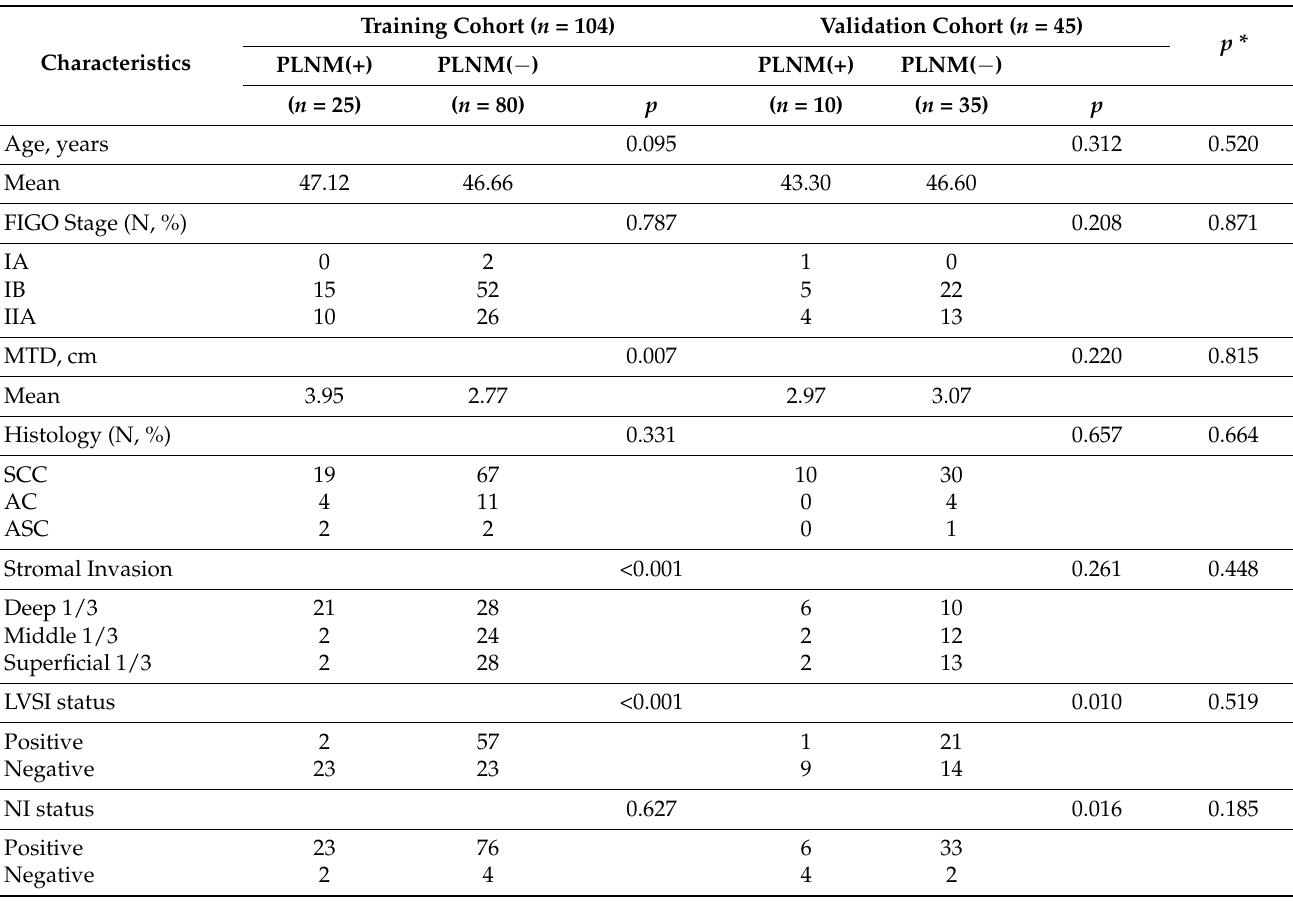
Table 1. Characteristics of the included